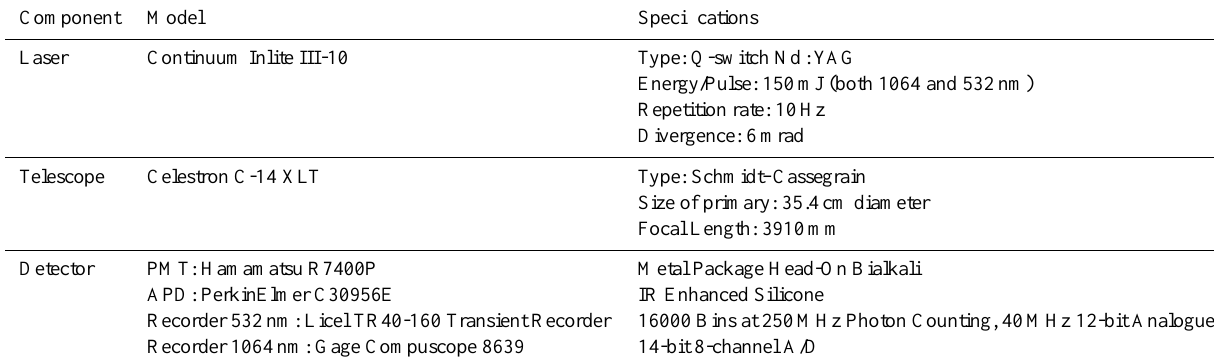
Table 1. Specifications of the major components of the aerosol lidar system.